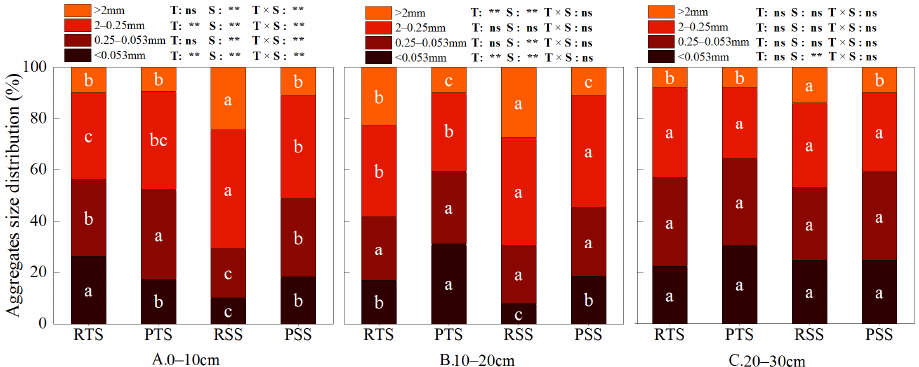
Figure 3. The distribution of water-stable aggregate fractions in soil under different tillage and straw return modes. RTS, rotary tillage with straw return; PTS, plow tillage with straw return; RSS, rotary tillage with straw strip return; PSS, plow tillage with straw strip return. ( A ) indicates topsoil (0–10 cm), ( B ) indicates mid-soil (10–20 cm), and ( C ) indicates subsoil (20–30 cm), respectively. Error bars represent the standard deviations of the mean ( n = 3). Different lowercase letters indicate significant differences between treatments ( p < 0.05). T, tillage; S, straw management; ** indicates extremely significant difference ( p < 0.01), ns indicates not significant.